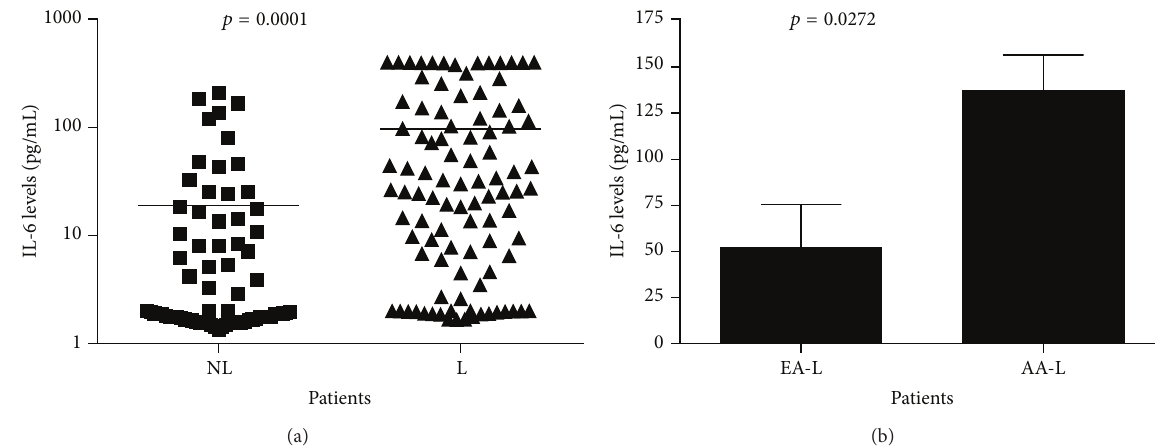
Figure 7: IL-6 serum levels in lupus and nonlupus patients. (a) shows that lupus patients have a significantly higher level of IL-6 compared to age-matched controls ( 𝑝 = 0.0001 ); however, (b) African American women with lupus have an increased level of IL-6 compared to European American women with lupus ( 𝑝 = 0.0272 ).